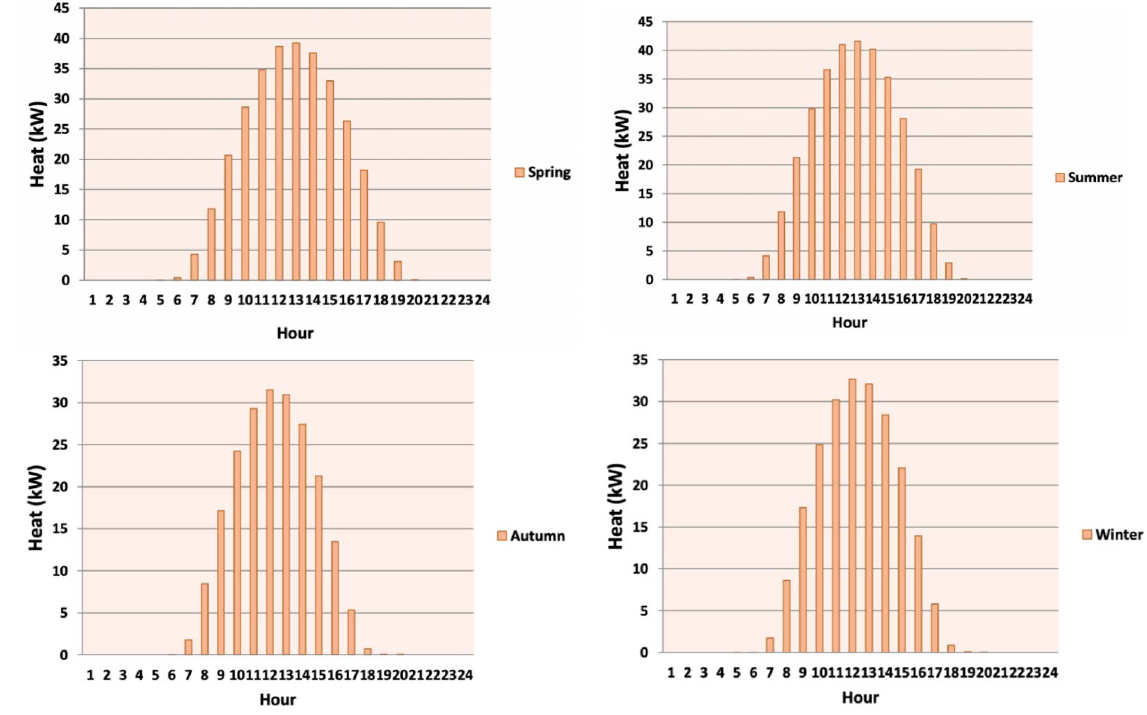
Figure 4. PV/T heat generation distribution based on time.